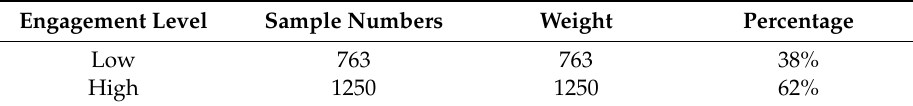
Table 3. Sample statistic of engagement level.